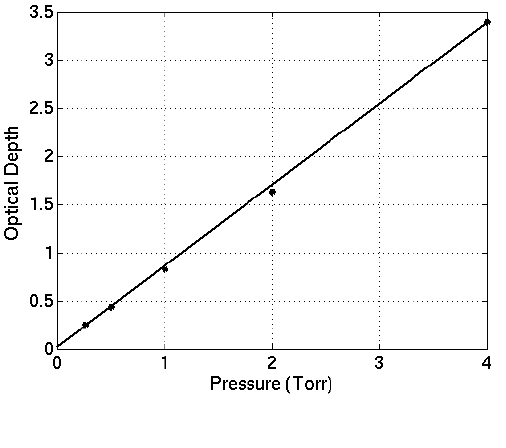
Figure 1. Maximum value of optical depth of CFC-113a versus pressure at 1227 cm − 1